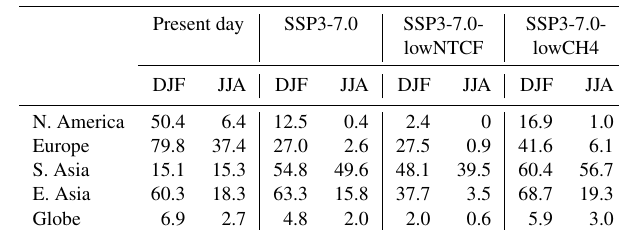
Table 5. The percentage of VOC-limited areas (%) in different regions under different pathways in winter (DJF) and in summer